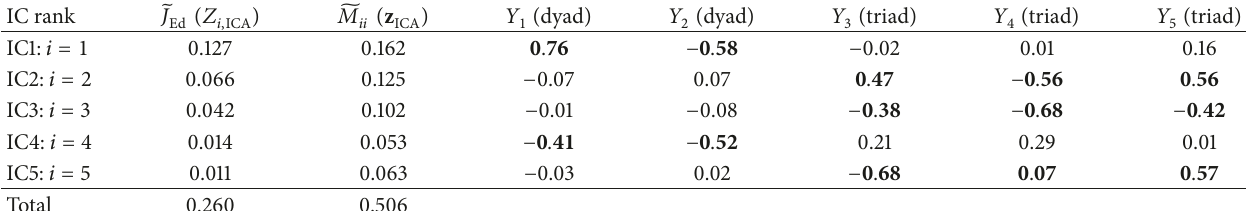
Table 3: Contributions to the ICA contrast function (2nd column). NE components (3rd column) and IC vector loadings on the basis of original variables (18) for the high noise case. Components in which ICs are most projected are in bold font.